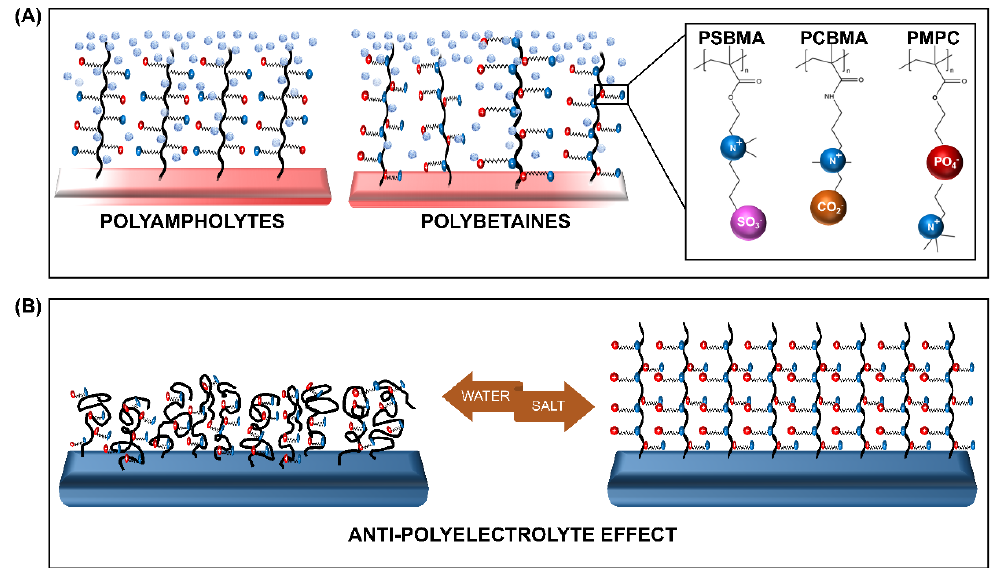
Figure 1. Schematic representation of the ( A ) zwitterionic polymers (ZPs) and ( B ) the salt-responsive antipolyelectrolyte effect (APE) of the ZP brushes. PSBMA—poly (sulfobetaine